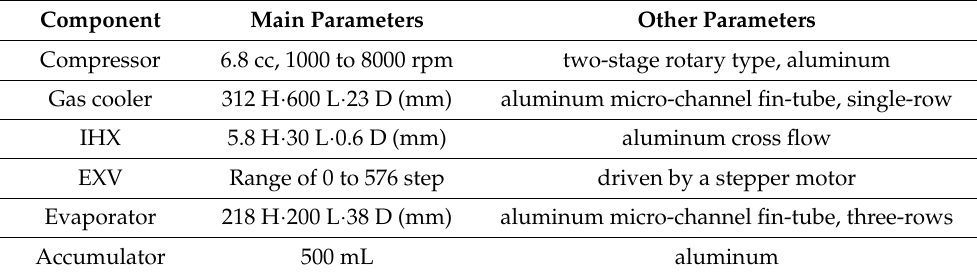
Figure 1. Schematic of the experimental setup of the transcritical CO 2 electric vehicle air conditioning system. 1—compressor, 2—gas cooler, 3—internal heat exchanger (IHX), 4—mass flow meter, 5—electromagnetic expansion valve (EXV), 6—heating, ventilation and air conditioning (HVAC) unit, 7—accumulator. Table 1. Detailed parameters of the components.